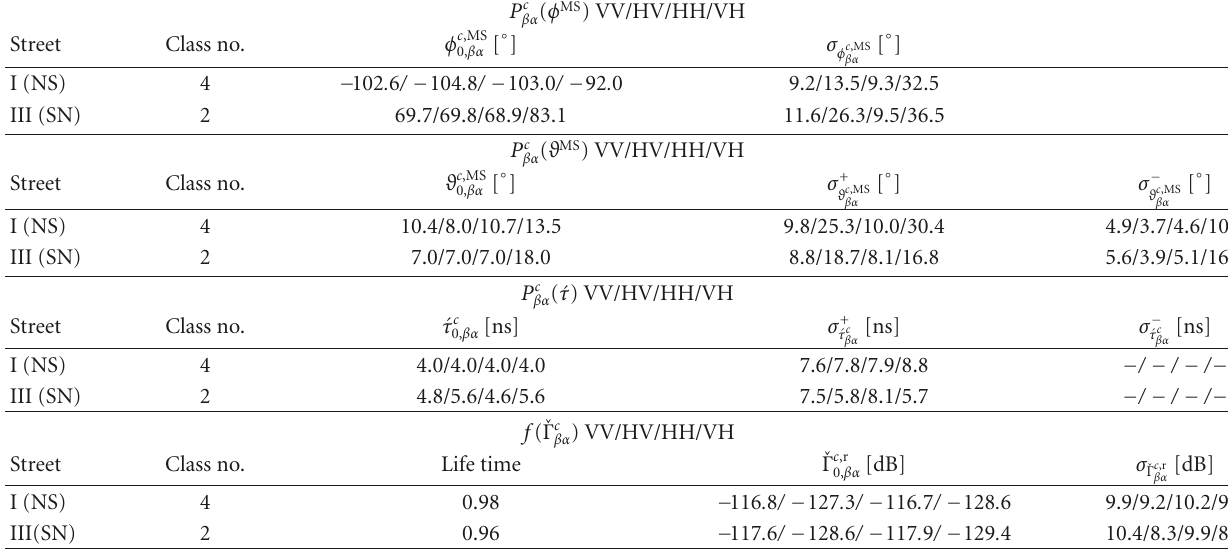
Table 7: Best-fit parameters of BS-direction classes for NLOS